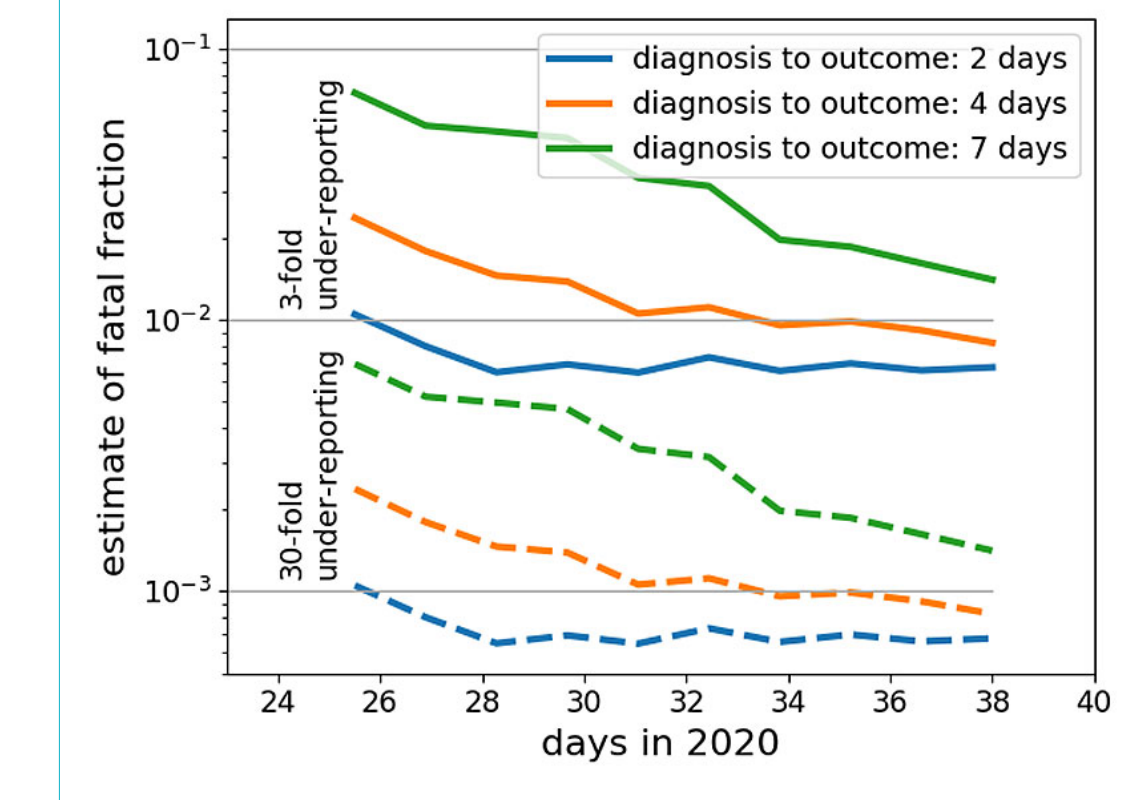
Figure 1: Uncertainties of naive case count estimates. This graph shows how the ratio of the number of confirmed deaths and case counts changed over time. Case counts are corrected for 3-fold or 30-fold under-reporting (solid and dashed lines, respectively) and are taken 2, 4, and 7 days prior to the date of the count of confirmed death. The latter is meant to illustrate the effect of the delay between diagnosis and death or recovery. This actual delay is likely longer than one week. Data source: https://github.com/globalcitizen/2019-wuhan-coronavirus-da-